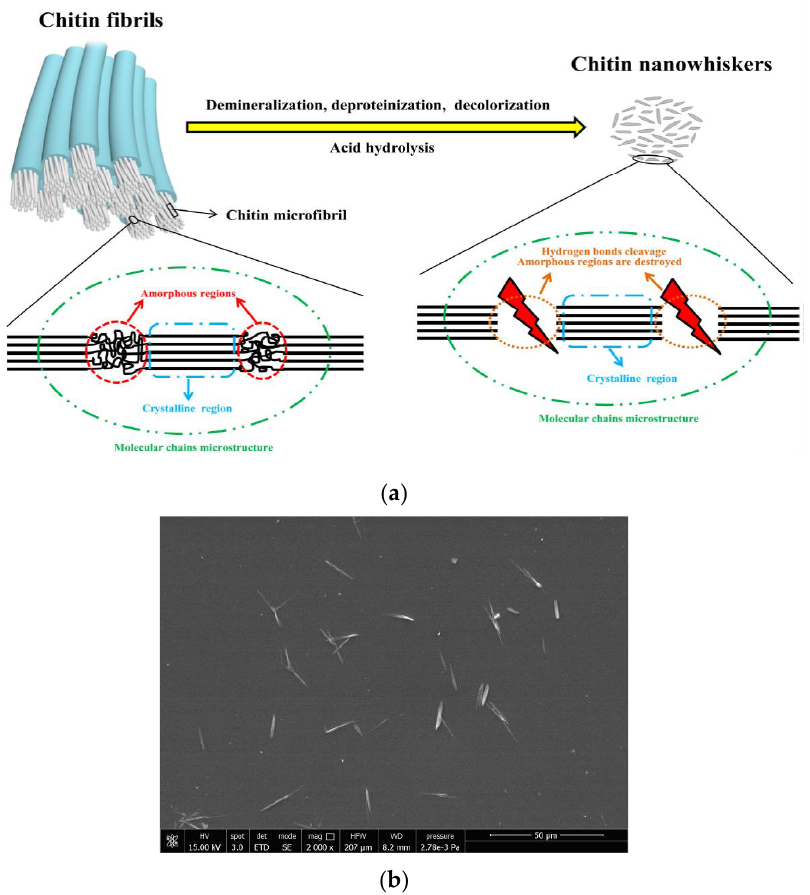
Figure 7. ( a ) Crystalline and amorphous structures of chitin nanofibrils (nanowiskers), in which the amorphous section is destroyed from 50% to 60%; ( b ) the needle-like structure of chitin nanofibrils.